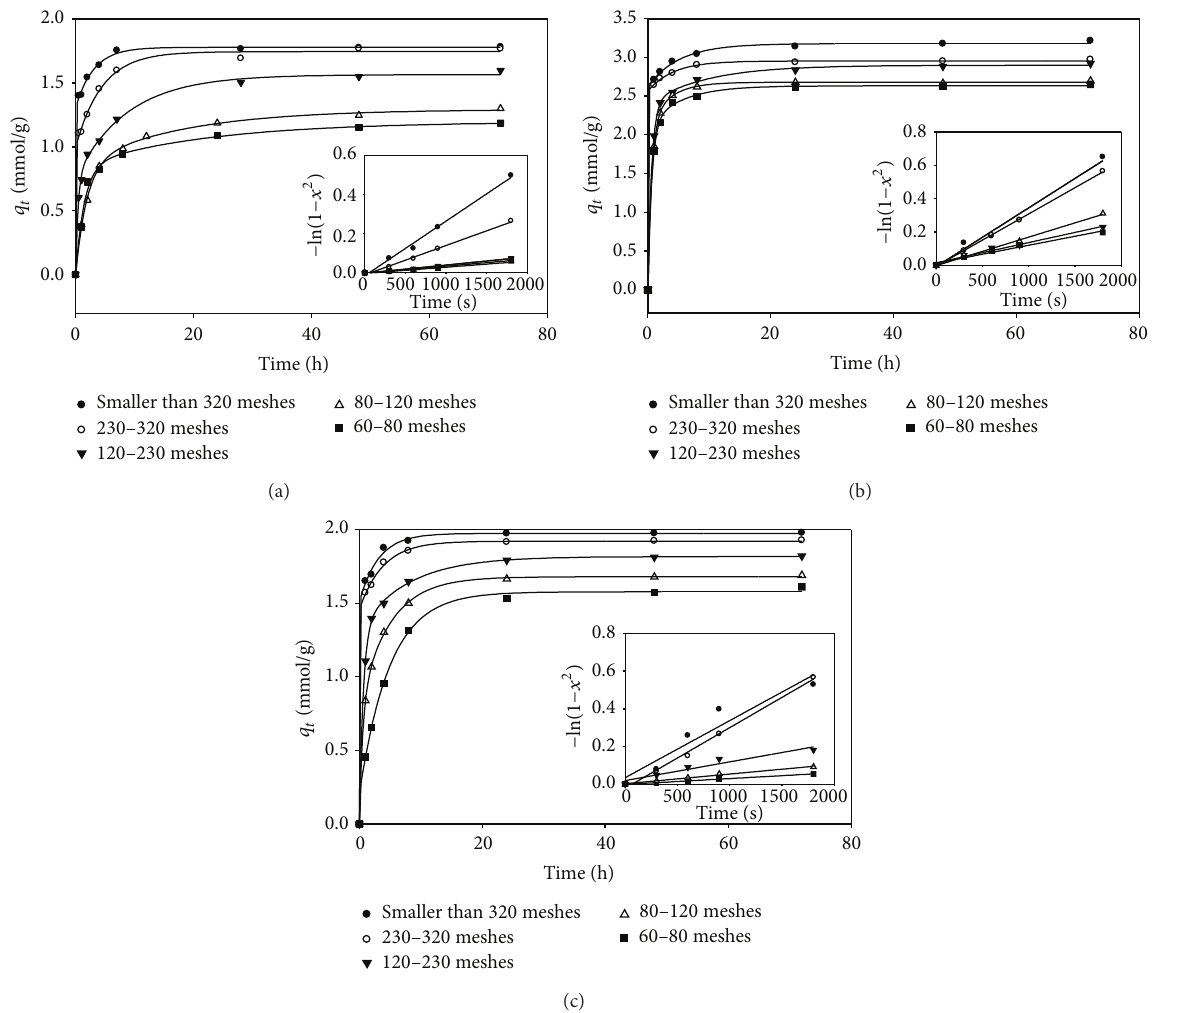
Figure 1: Effect of particle size on adsorption capacity of (a) diclofenac, (b) acetaminophen, and (c) sulfamethoxazole (stirring speed of 140rpm for 72 h and 25 ∘ C. The initial concentration of each target compound was 10mg/L).